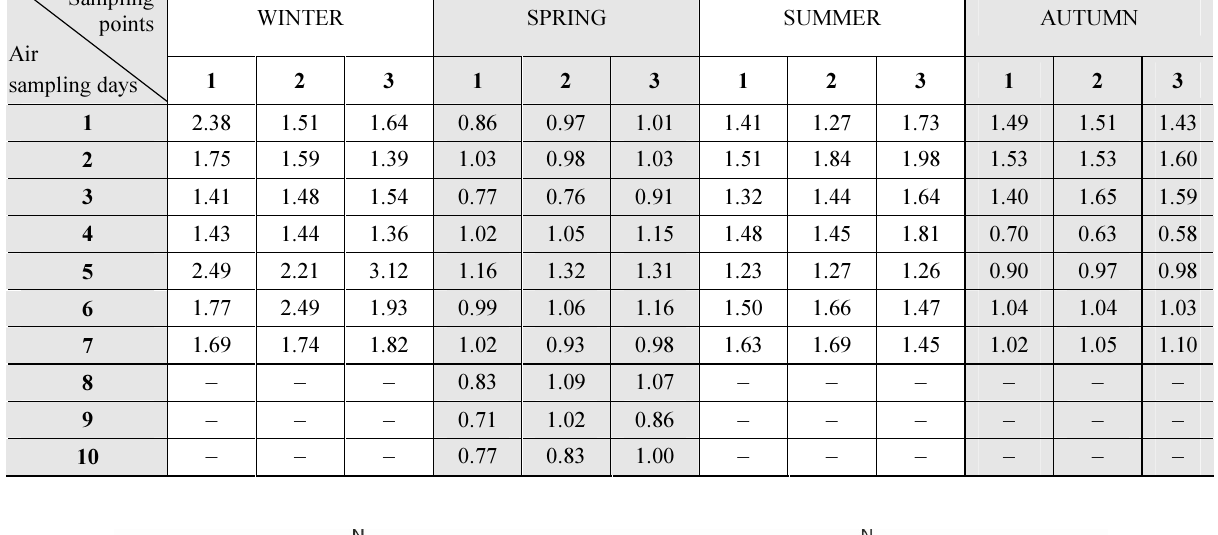
WINTER SPRING SUMMER